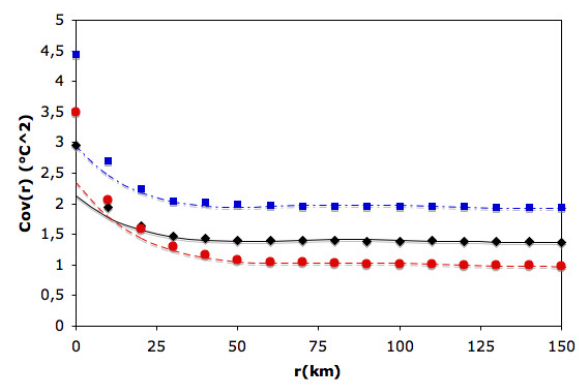
Fig. 4. Binned innovation covariance for minimum (squares), mean (diamonds), and maximum (circles) temperatures. The curves (dot- dash, solid, and dash for minimum, mean, and maximum tempera- tures) are 6th order polynomial fittings of the binned